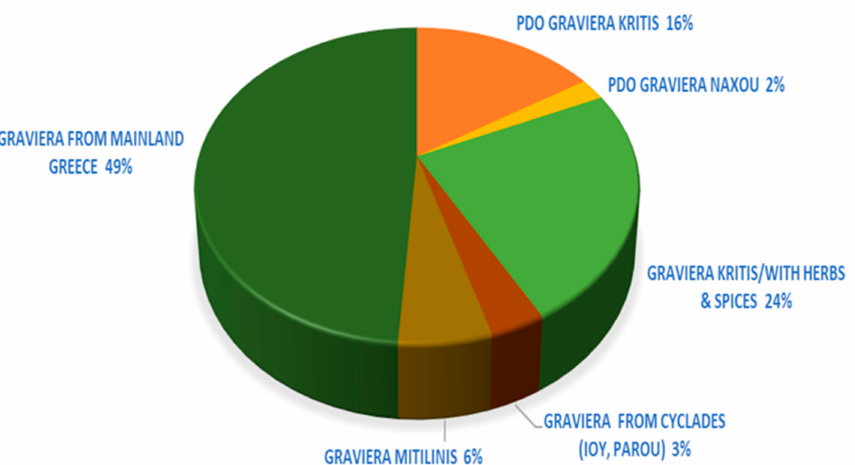
Figure 1. Pie-chart of the origin of all pre-packed gravieras’ with or without a Protected Designation of Origin (PDO) mark, as a percentage of the sum of the products tested in the Greek